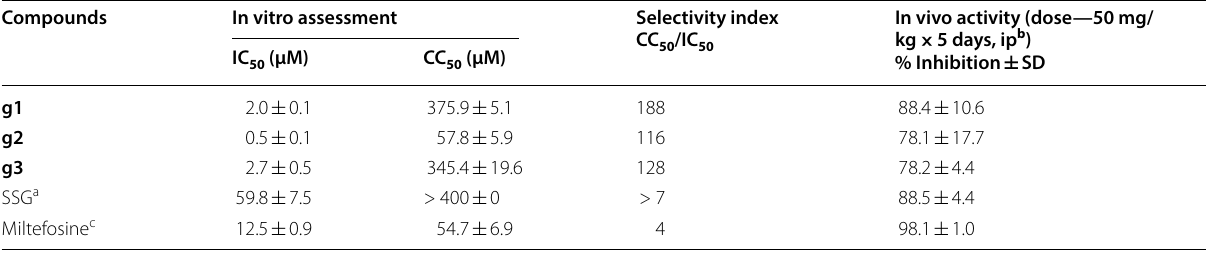
IC 50 and CC 50 values are the mean The selectivity index is defined as the ratio of CC 50 on vero cells to IC 50 on L. donovani intramacrophagic amastigotes